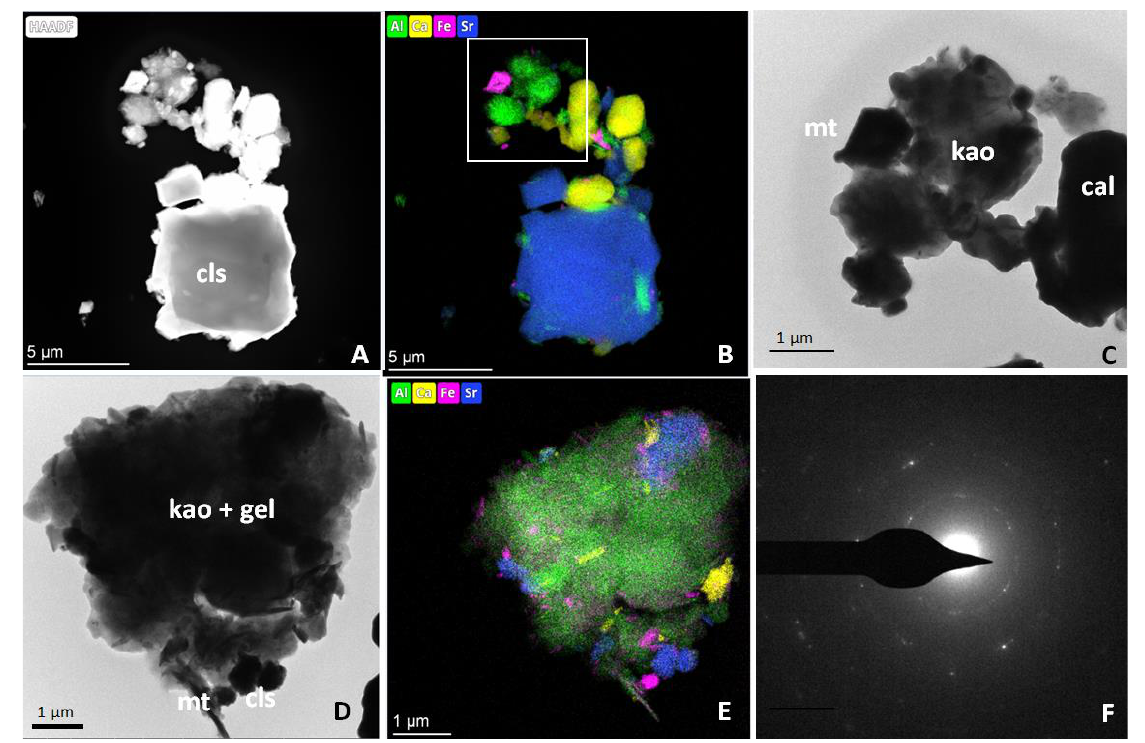
Figure 4. Transmission electron microscopy of E60 sample. Morphology and chemical analysis of mineral assemblages shown in ( A ) and ( D ) studied using different imaging modes: ( A ) STEM mode; ( B – E ) EDX maps showing distribution of relevant chemical elements (Sr in blue, Ca in yellow, Al in green, and Fe in pink). ( C , D ) Bright field image of mineral assemblage detail (from B ) and general view ( D ); ( F ) SAED pattern of magnetite nanoparticle. Main mineral phases identified are indicated as follows: cls, celestine; cal, calcite; kao, kaolinite; mt, magnetite. Scale bars: (A,B): 5 µm; C – E: 1 µm.